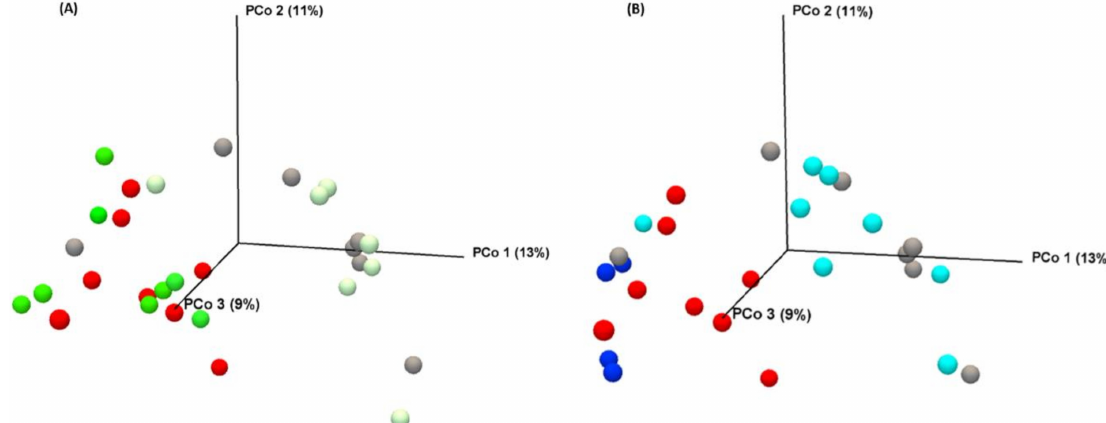
Figure 6. Bacterial profile between different interventions at day 4, after MTX insult. ( A ) PCoA plot of microbial composition (Bray–Curtis dissimilarity on taxomomic level of genera) after vitamin C supplementation. ( B ) PCoA plot after vitamin B2 supplementation.